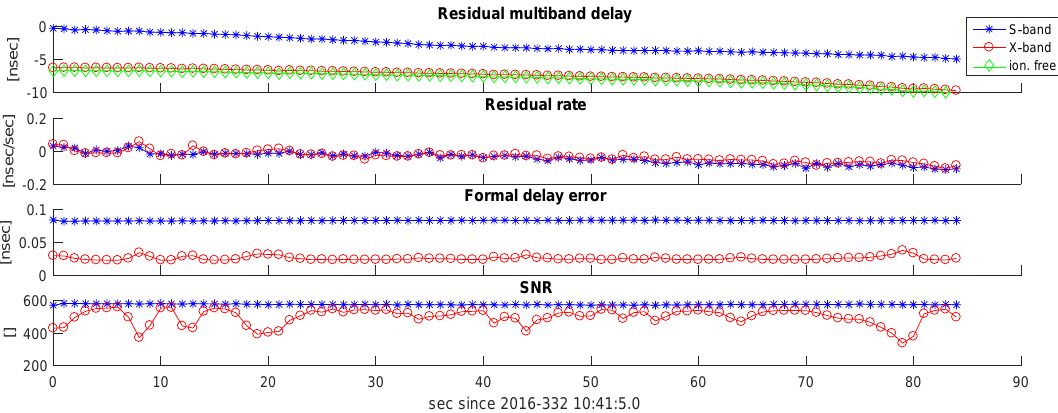
Figure 9. Fourfit results of Scan 168 in Experiment a332. Residual multi-band delays, residual delay rates, formal delay errors, and SNRs are plotted versus time, indicated as seconds since scan start.